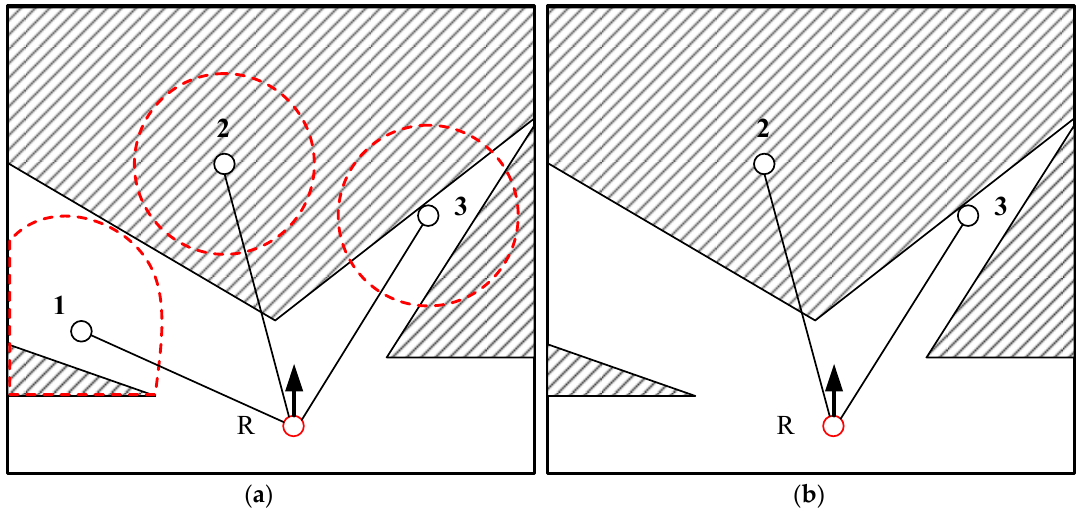
Figure 4. Establishing the candidate topology node: ( a ) generation of candidate topology nodes; ( b ) update of the topology map.